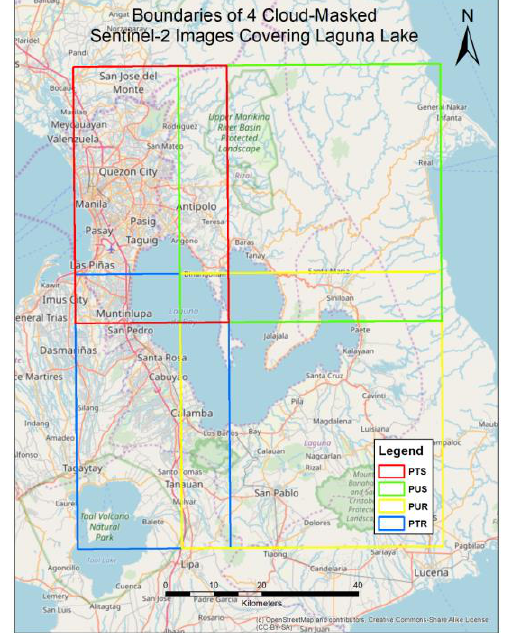
Figure 1 boundaries of 4 cloud-masked Sentinel-2 images covering Laguna